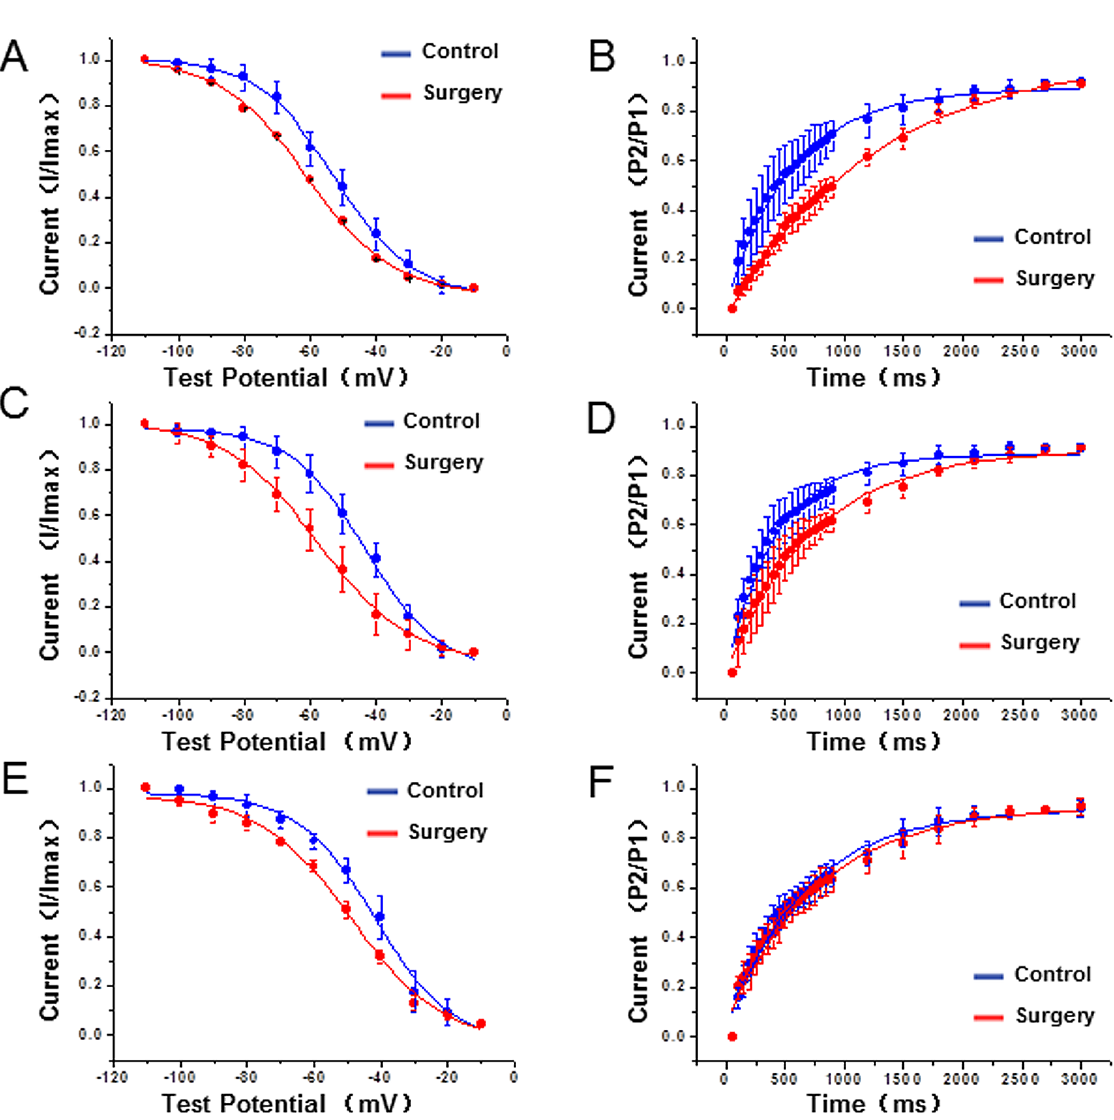
Fig 5. Characteristics of the steady-state inactivationcurves (A, C, E) and inactivationrecovery curves (B, D, F) of I Kur at different regions, including the epi-myocardium (A, B), endo-myocardium(C, D) and right ventricle (E, F) in both groups. https://doi.org/10.1371/journal.pone.0183671.g005 PLOS ONE | https://doi.org/10.1371/journal.pone.0183671 September 1,